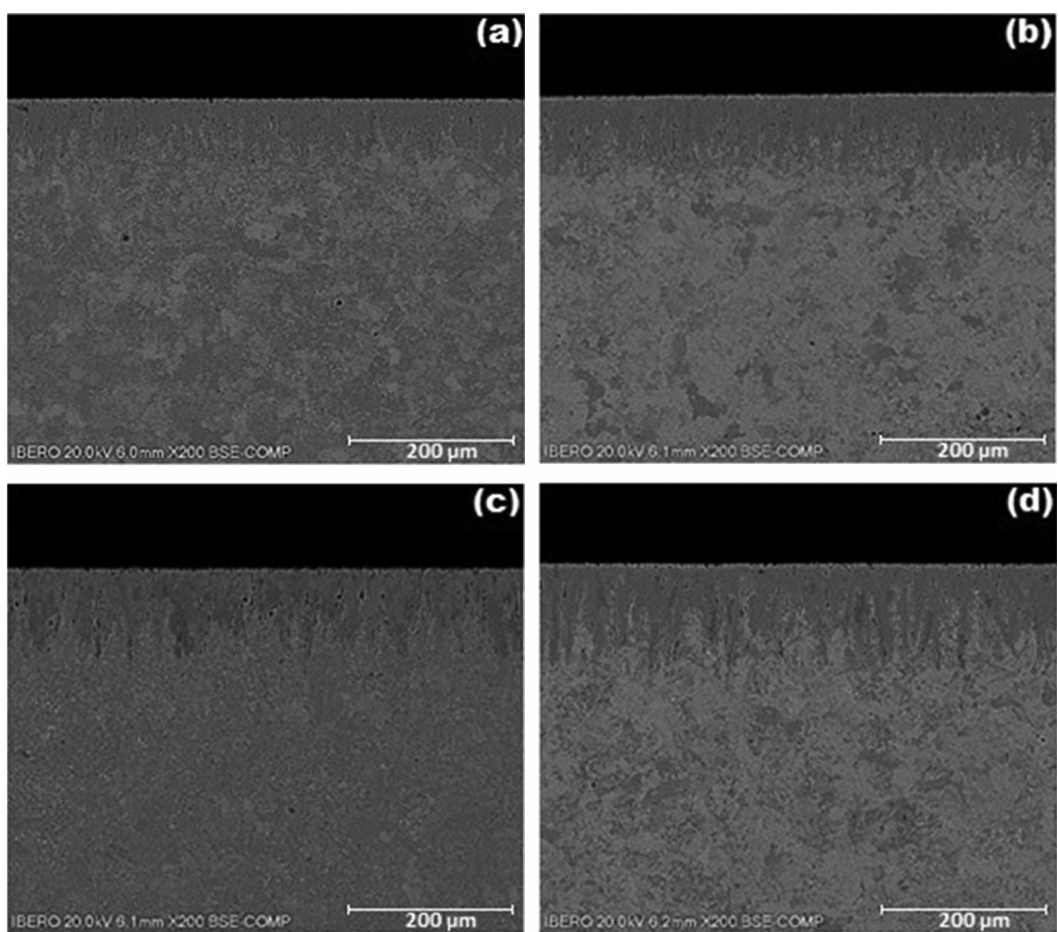
Figure 2: SEM micrographs of the cross-sections of AISI 1518 steels borided at 1173 K during different exposure times: (a) 2 h, (b) 4 h, (c) 6 h, and (d) 8